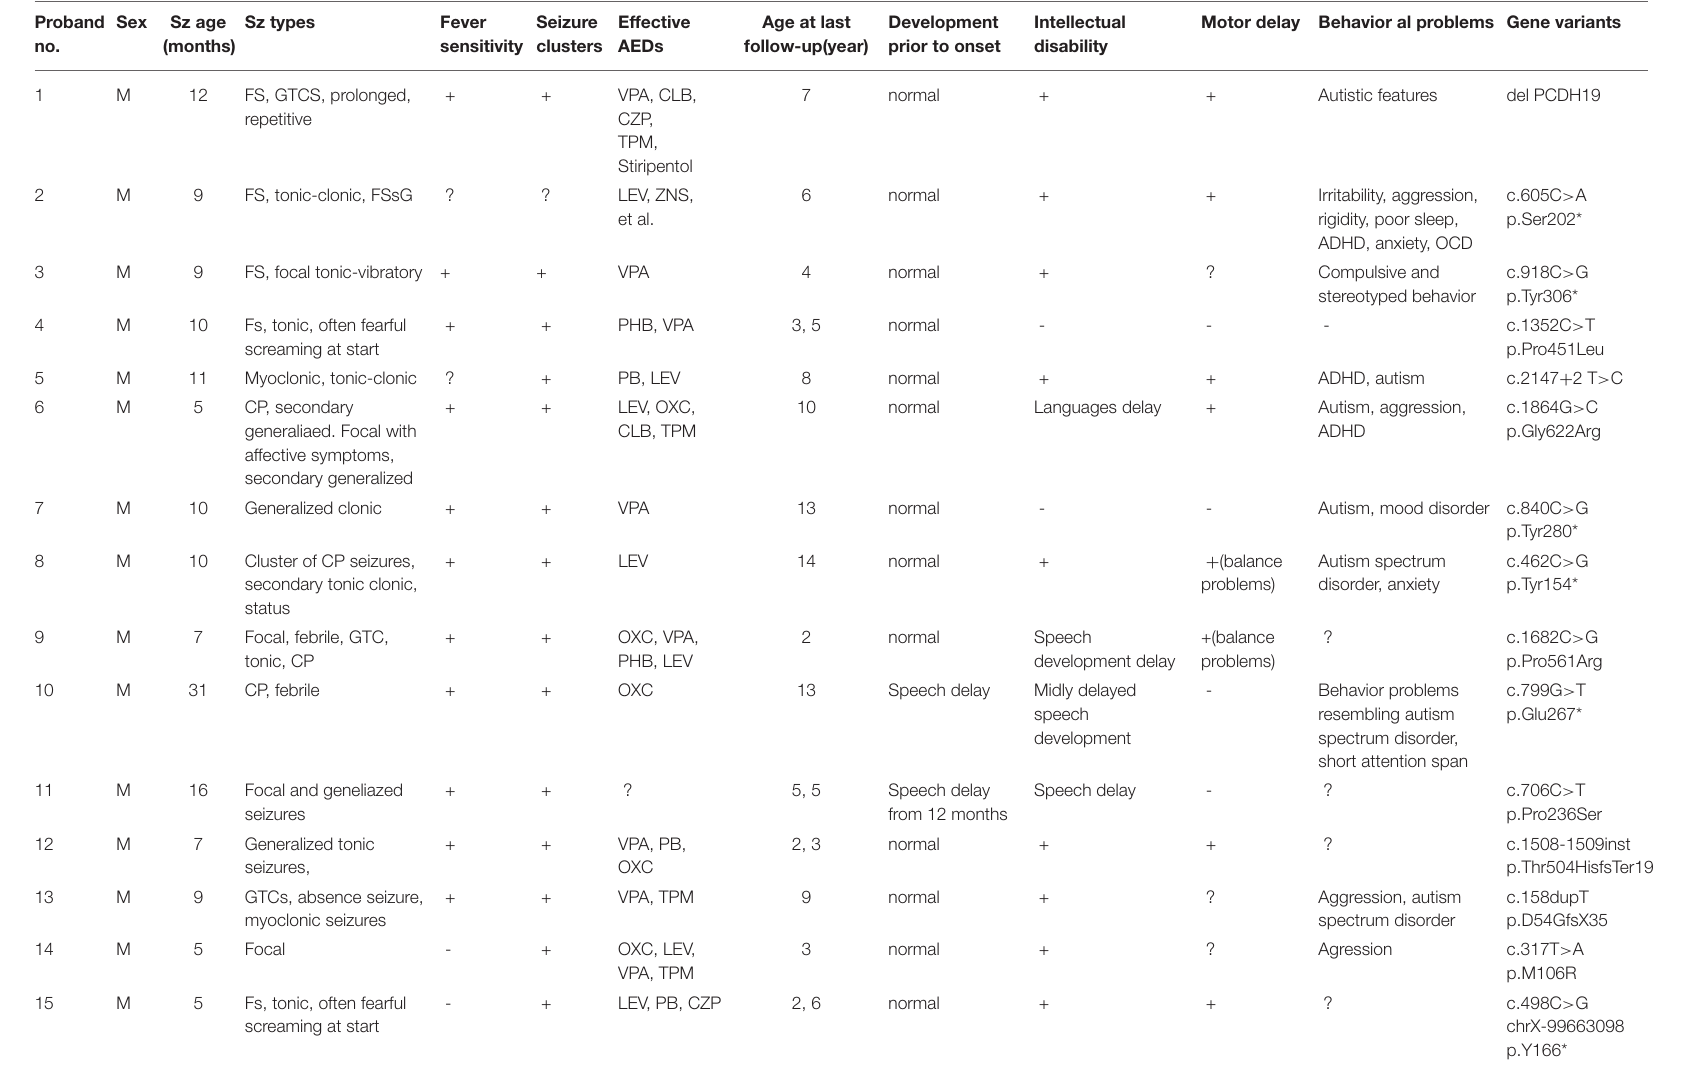
TABLE 1 | Clinical manifestation of 15 male patients with PCDH19 gene variants. Proband